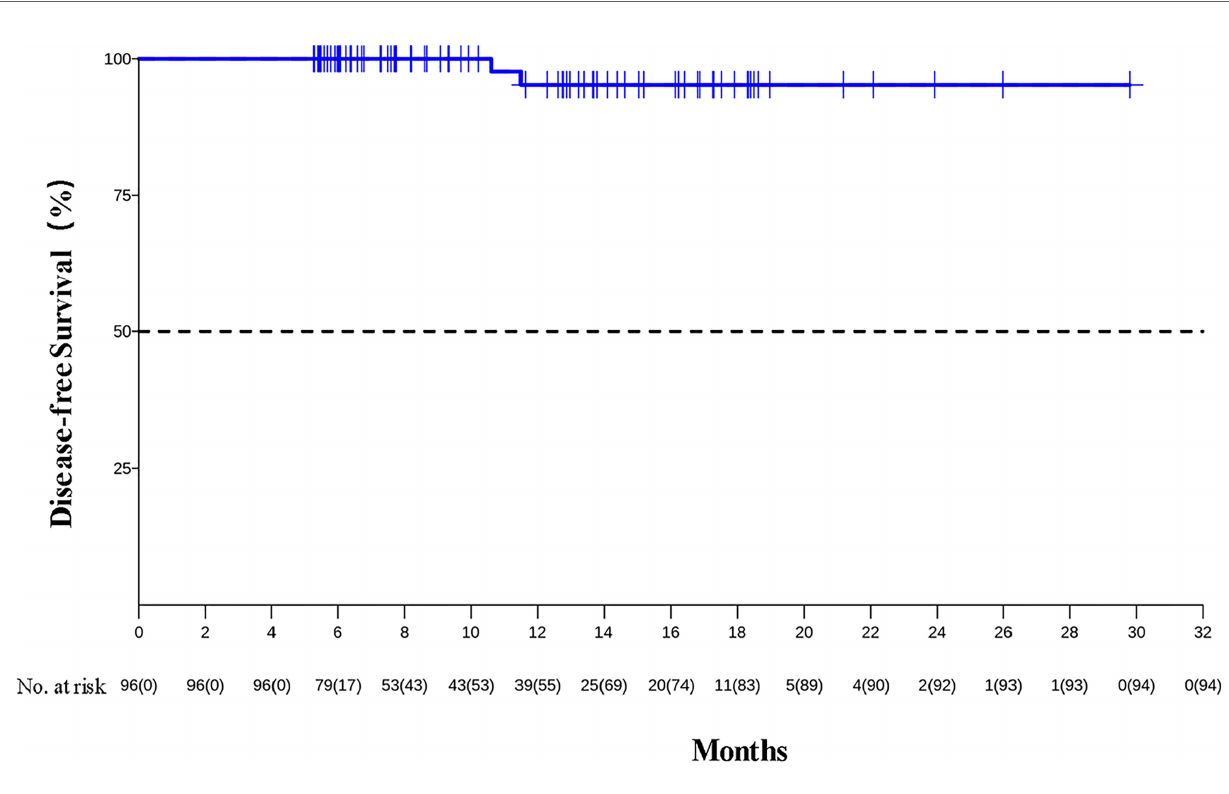
FIGURE 1 | Kaplan – Meier estimates of DFS.